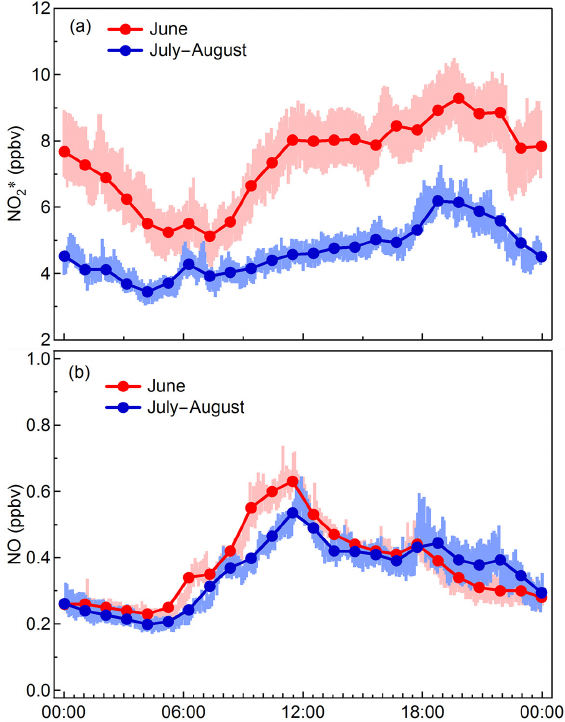
Figure 4. Average diurnal variations of (a) NO ∗ Mt. Tai in June and July–August derived from the continuous obser- vations from 2006 to 2009. The shaded area indicates the standard error of the